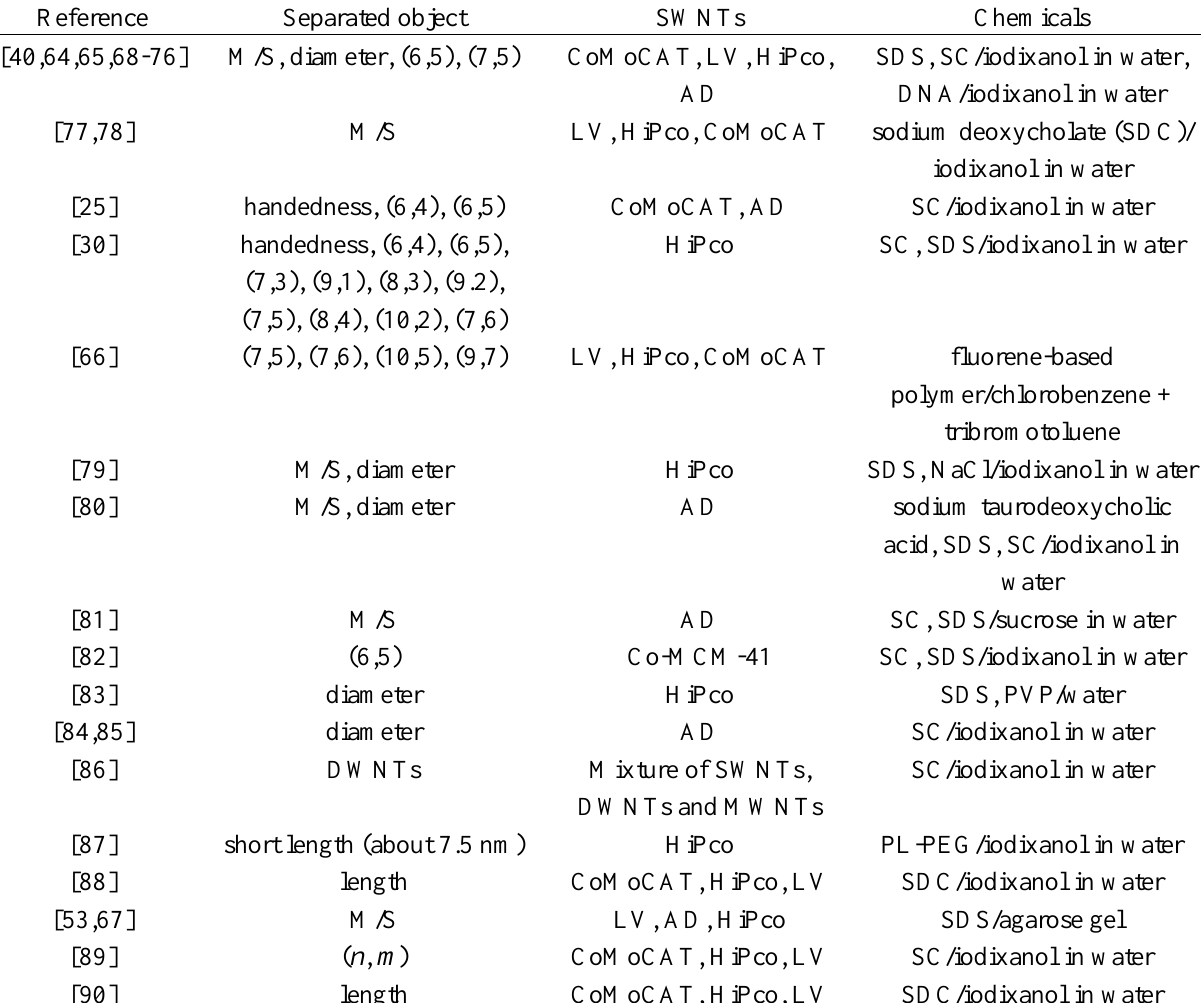
Table 2. Separation of SWNTs by density gradient ultracentrifugation